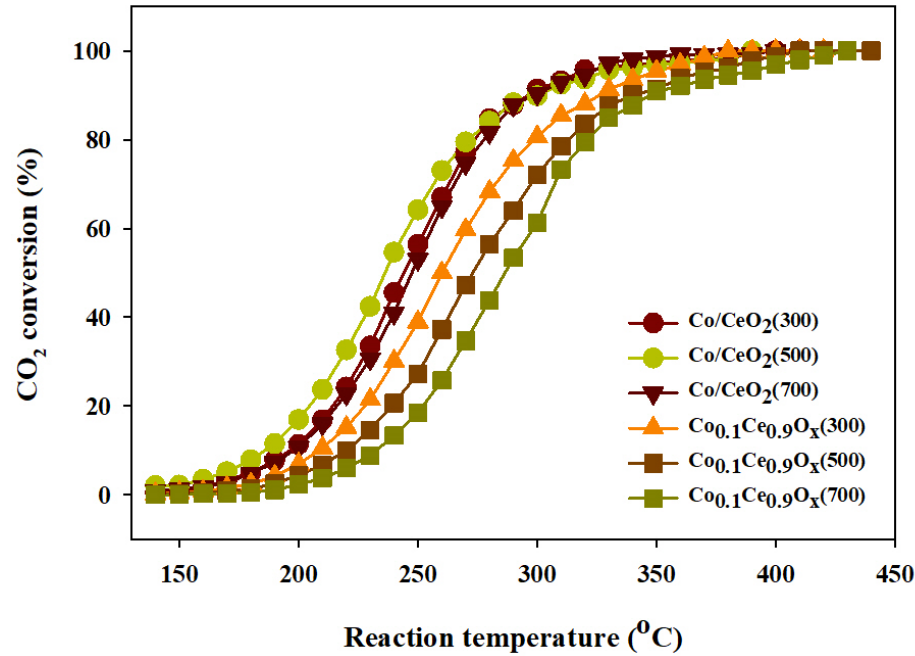
Figure 4. Catalytic activity for CO 2 methanation over ceria-supported cobalt catalysts. All catalysts were reduced in H 2 at 500 °C. The feed gas is composed of 1 mol% CO 2 , 49 mol% He, and 50 mol% were reduced in H 2 at 500 ◦ C. The feed gas is composed of 1 mol% CO 2 , 49 mol% He, and 50 mol% H 2, and the total flow rate is 100 mL/min. H 2, and the total flow rate is 100